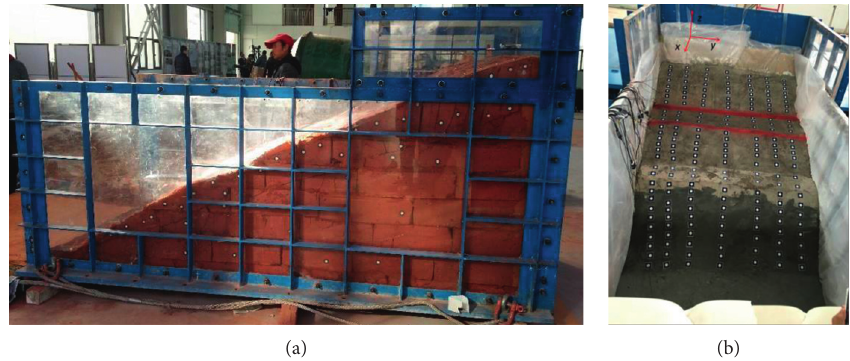
Figure 10: Soil container and the scaled model: (a) Huaping slope; (b) Lijiang slope.